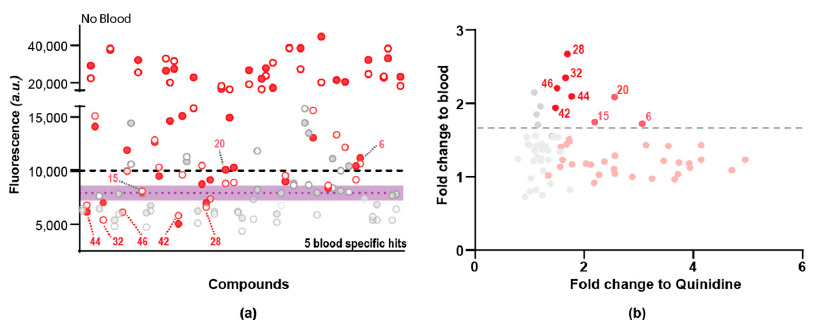
larvae N. brasiliensis with reference to quinidine as positive control (QND, 32 replicates per plate) and to DMSO 1% as negative control (DMSO, 32 replicates per plate). All test and positive control compounds were tested at 100 µ M in the presence or absence of blood in duplicates. Each grey or red dot represents an individual test compound. Mean +/ − SD for controls were calculated as an average of all replicates ( n = 224) and are indicated in purple for DMSO. All values were normalised for each plate to mean (DMSO) + 3 ∗ SD(DMSO) = 10,000 units (Dashed black line). Red dots are compounds identified as hits in presence of blood (39 compounds, screen 2, as described in Figure S1). ( a ) Normalised fluorescence intensity obtained for each of the 66 hits in absence of blood. ( b ) For each of the 66 compounds, the fold change of Sytox green intensity between screen 2 (in presence of blood) and screen 3 (in absence of blood) is represented as a function of the Sytox intensity as compared to the reference drug quinidine in presence of blood. The dash grey line has been set manually to separate hits with the higher fold change between absence and presence of